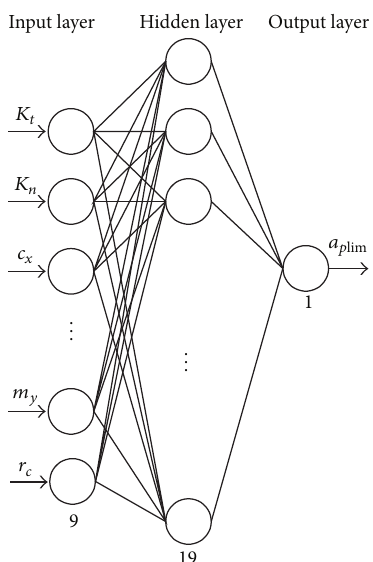
Figure 2: Topological structure of the BP neural network model used in this study.